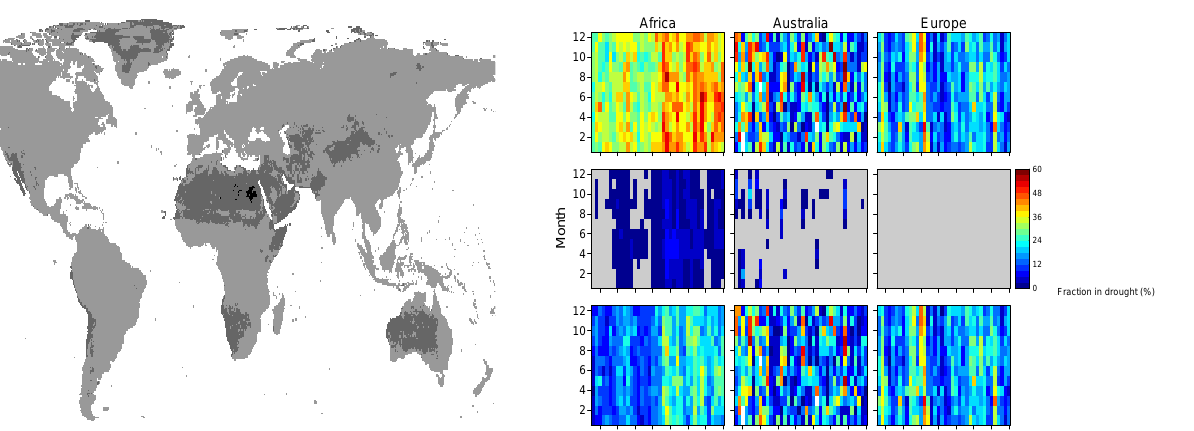
Fig. 12. Fraction in drought (%) of the area for 3 continents (Africa, Australia and Europe) as identified with the different methods from the ensemble median of 5 LSMs. Top row: TLM; middle row: CDPM; bottom row: combined